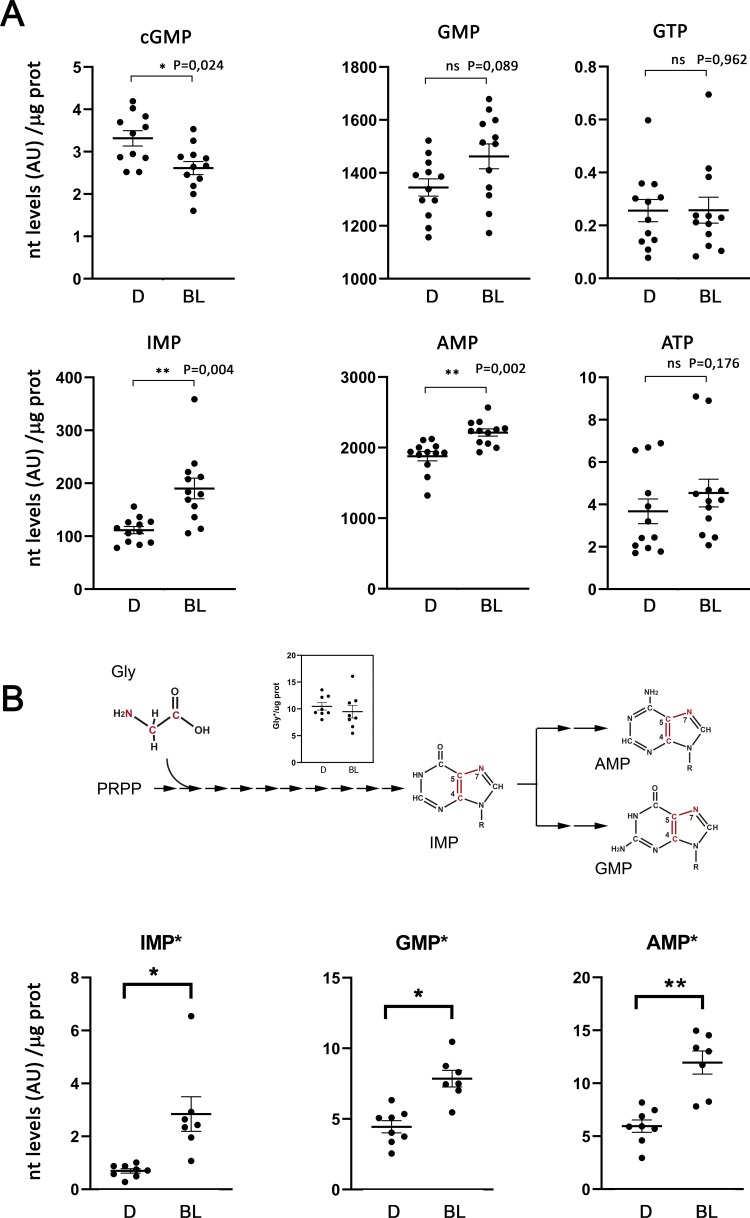
Light exposure increases the flux through de novo purine nucleotide synthesis in the retina.Metabolic flux analysis through de novo purine nucleotide synthesis was performed by injecting 13C2;15N-Glycine intravitreally (to 4 mM final concentration in the vitreous) to dark-adapted mice, that were then kept in the dark or exposed to 1600 lux light for 4 hr. Total nucleotide levels and labeled nucleotide levels (that incorporated the labeled carbon and nitrogen atoms from labeled glycine) were determined by LC/MS-MS, and normalized per μg of protein in each sample. (A) Retinal levels of total cGMP, IMP, AMP, GMP, ATP and GTP in dark-adapted mice (D); or bright-light-exposed mice (BL). Nucleotide levels are expressed in arbitrary units (LC-MS/MS peak integration values) normalized per μg of protein in each sample. cGMP levels decreased with light exposure, as expected [p=0,024, n = 12]. IMP levels showed a clear increase with light exposure [p=0004]; that was accompanied by an increase in AMP and GMP levels [p=0002 for AMP; p=0089 for GMP]; whereas the ATP and GTP levels were maintained. (B) Retinal levels of labeled IMP, GMP and AMP, normalized per μg prot. The labeled atoms from Gly* that are incorporated into the purine ring scaffold are shown in the diagram. The inset on the diagram shows that the levels of Gly* measured at the retinas of injected eyes were similar in dark and bright light samples. Incorporation of Gly* into IMP, AMP and GMP increased under bright-light exposure, indicative of an increase in the overall flux of de novo purine nucleotide synthesis [IMP*, p=0,020; AMP*, p=0,003; GMP*, p=0,013, with n > 7]. In four eyes of the ‘dark’ group of mice, and five eyes of the ‘bright light’ group of mice the injection failed [the injected Gly* did not reach the retina, and Gly*~0 in retinal extracts] and therefore could not be taken into account for determination of labeled nucleotides.